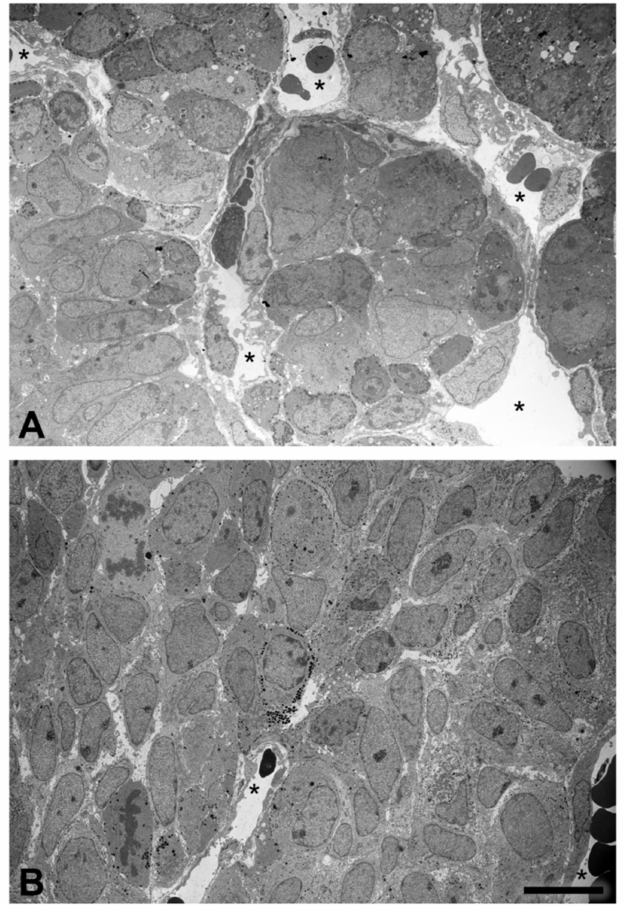
Figure 9. Transmission electron microscopy of cell cluster organization in the neonatal anterior pituitary gland of the control ( A ) and BPA-treated groups ( B ). Note: the capillary lumens (asterisks). Scale bar: 10 µ